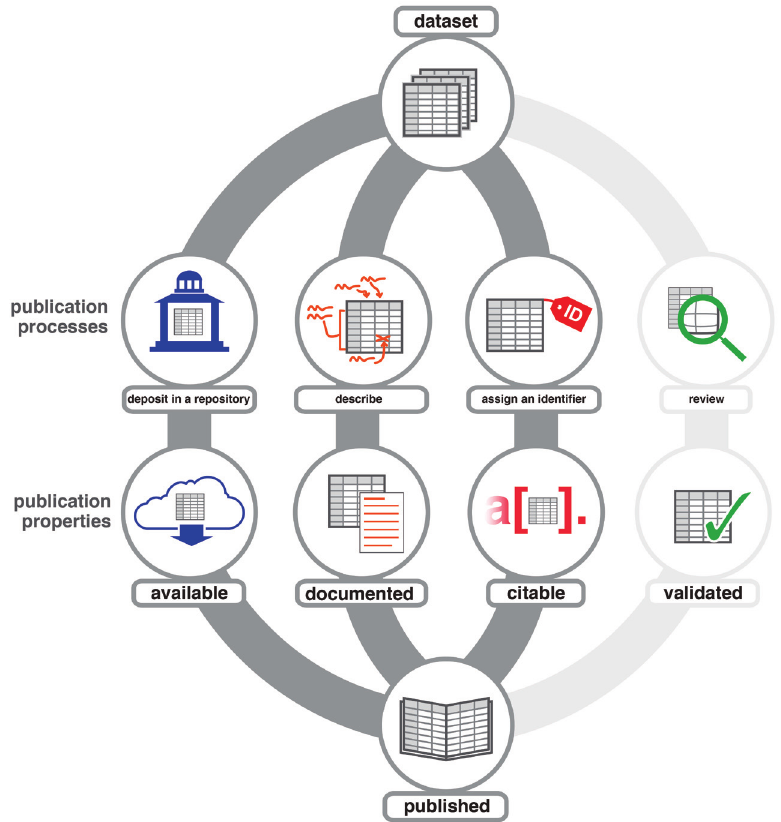
Figure 1. To be published, datasets are typically deposited in a repository to make them available, documented to support reproduction and reuse, and assigned an identifier to facilitate citation. Some, but not all, publishers review datasets to validate